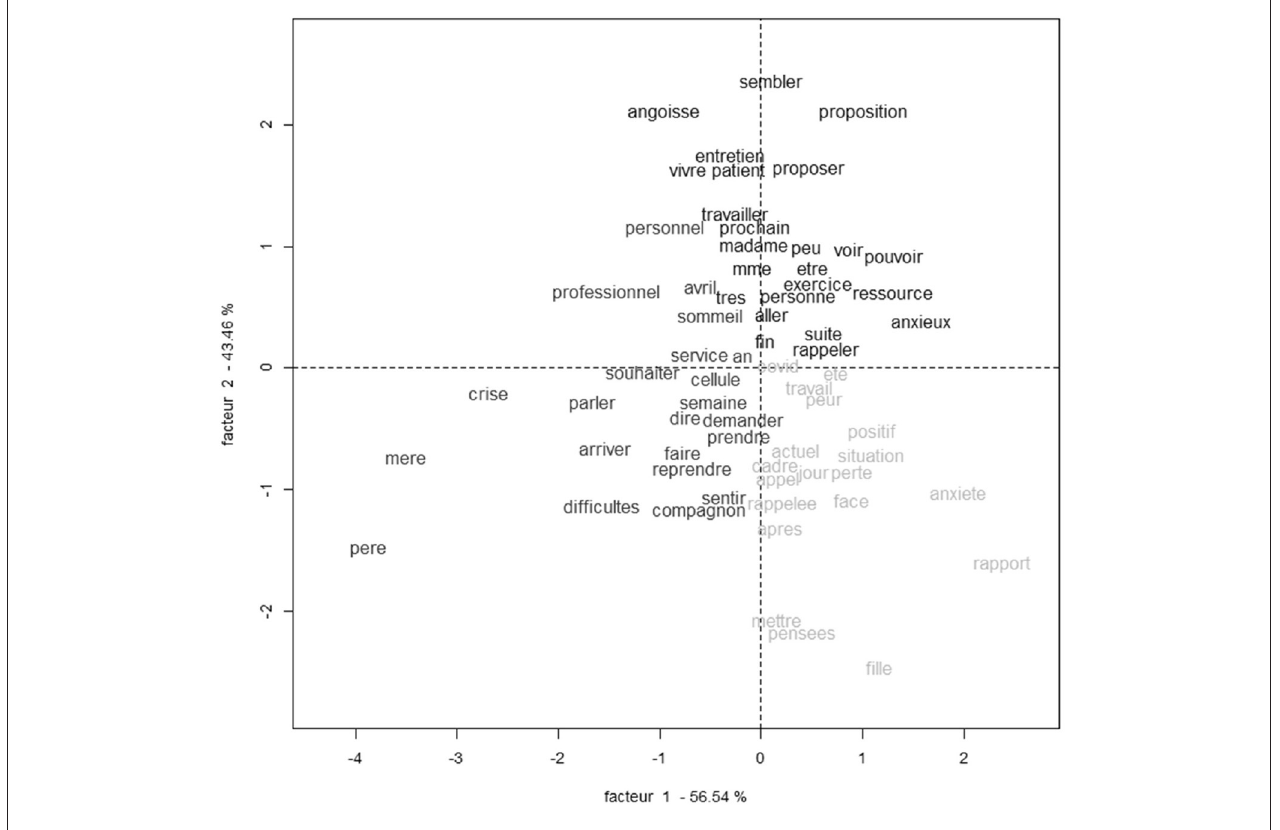
FIGURE 3 | Graphical representation of two dimensions’ correspondence factor analysis based on class of age and forms of each class of age with the highest relative frequency in this class.